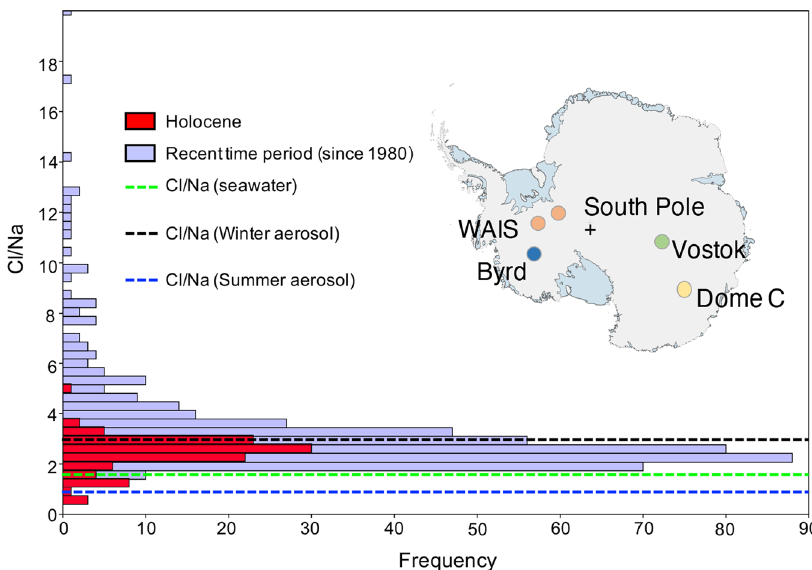
Fig. 7 Cl/Na ratios for the recent period and from Holocene. Comparison of modern and Holocenic Cl/Na in ice cores and aerosols over a recent period from WAIS ice cores 53,54 ; last 10k years B.P. period in Dome C 30,65 , Vostok Station 30 , Byrd Station 30,68 and in the Geographic South Pole 69 . The dotted lines indicate an average Cl/Na (1.8) of bulk seawater 30 ; average of Cl/Na in aerosol ( fi ne mode) measurements in summer (1.4) (blue) and winter (3.3) 23 .